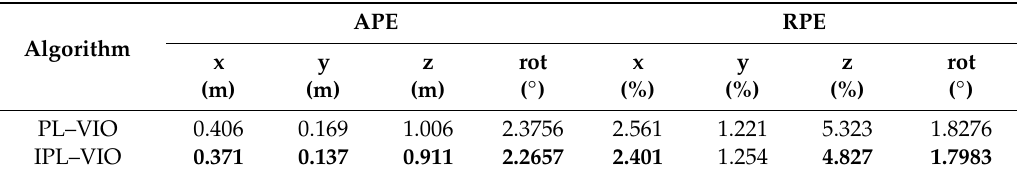
Figure 13. Point and line features matching in the PennCOSYVIO dataset: ( a , b ) are the matching of line features, and the line of the same color is the matched line feature; ( c , d ) are the matching of point features, the point of the same color is tracked by the optical flow [12]. Table 3. Absolute and relative pose error (APE and RPE) of the trajectory by running PL–VIO and IPL–VIO on the PennCOSYVIO dataset.